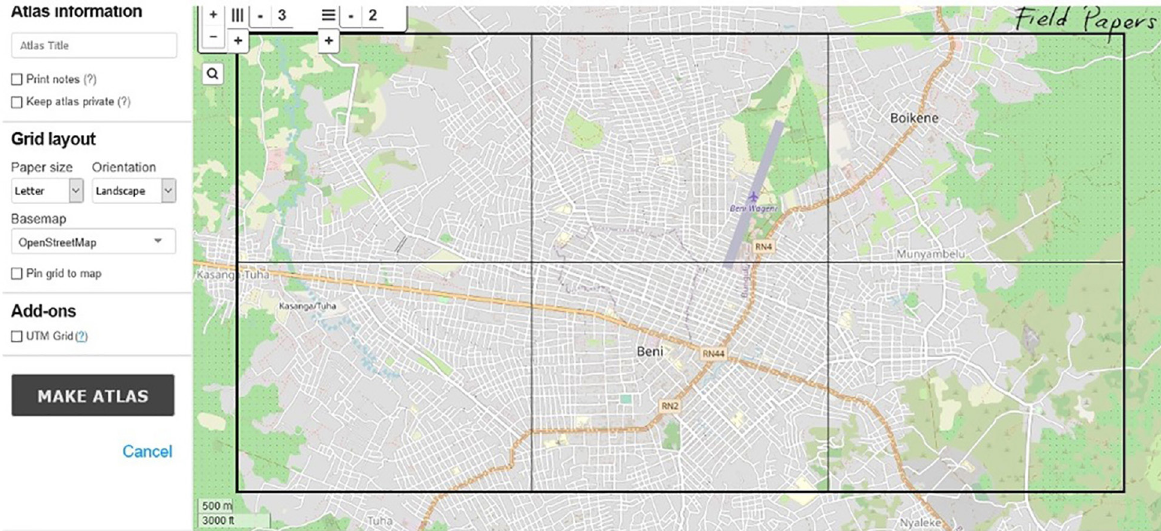
Fig. 7. Preparatory screen in Field Papers to obtain a map in a pdf format of the city of Beni, North Kivu Province